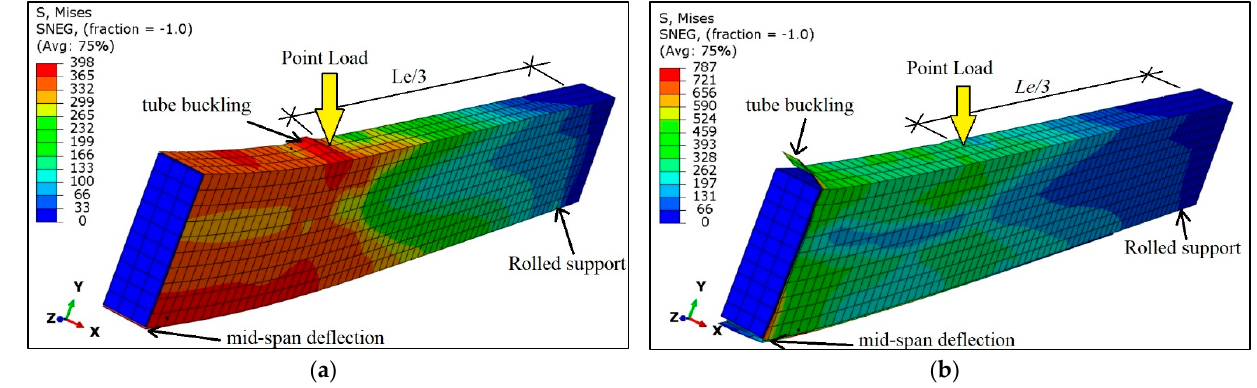
Figure 17. CFSST FE model failure mode. ( a ) MC100 and ( b ) MC100-N-3CFRP.